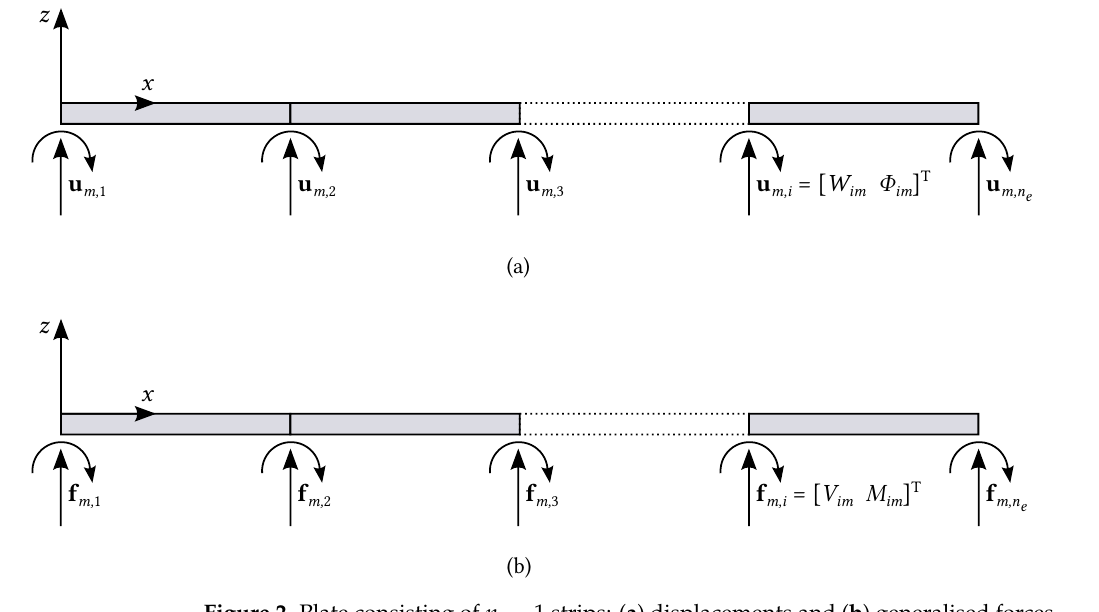
Figure 2. Plate consisting of n e − 1 strips: ( a ) displacements and ( b ) generalised